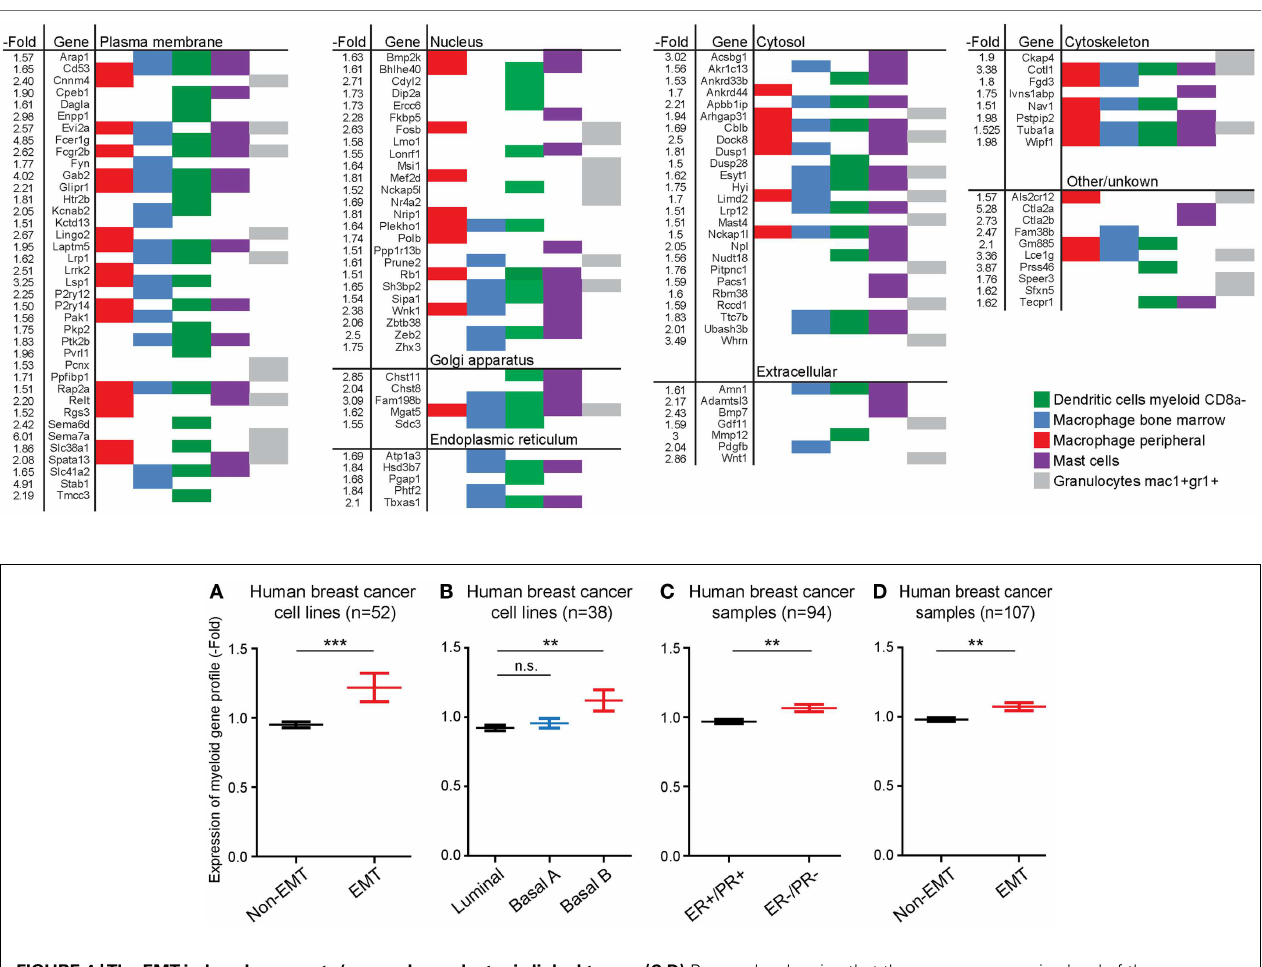
FIGURE 4 |The EMT-induced monocyte/macrophage cluster is linked to EMT in human breast cancer . (A,B) Bar graphs showing that the average expression level of the EMT-induced monocyte/macrophage cluster was increased in human breast cancer cell lines displaying EMT vs. non-EMT properties, and in basal B cells compared to luminal and basal A cells.